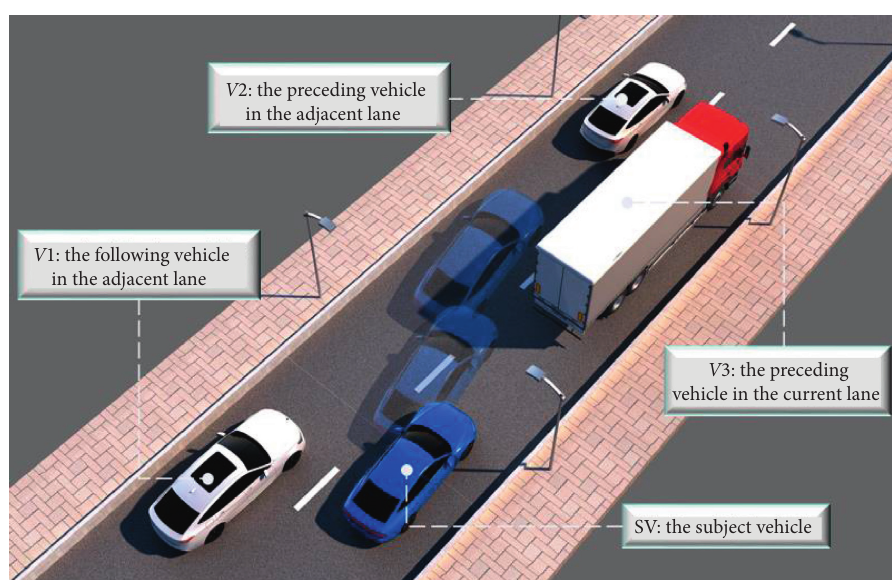
Figure 1: Lane-changing vehicles and surrounding